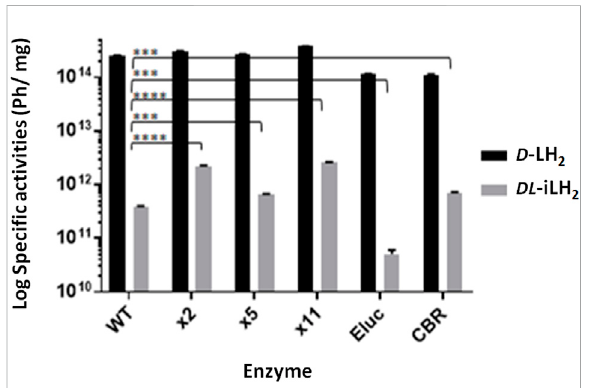
FIGURE 2 Speci fi c activities of WT Ppy Fluc, thermostable Ppy -based Fluc mutants, Eluc, and CBR with DL -iLH 2 . Speci fi c activity of 0.16 μ M enzymes at pH 7.3 in PEM buffer, 200 μ M D -LH 2 or DL - iLH 2 and 2 mM ATP, and emission was captured for 3 min through the open fi lter in the PIO. p -values for t -test of activity with DL -iLH 2 between WT Fluc and x2 ( > 0.0001), x5 (0.0003), x11 ( > 0.0001), Eluc (0.0001), and CBR (0.0002).